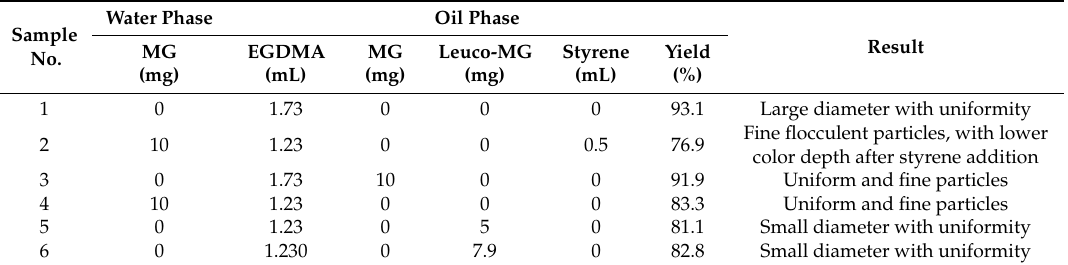
Table 1. Formulation used to synthesize molecularly imprinted polymer microspheres (M-PMs) and polymer microspheres (PMs) by Pickering emulsion polymerization. Sample No.